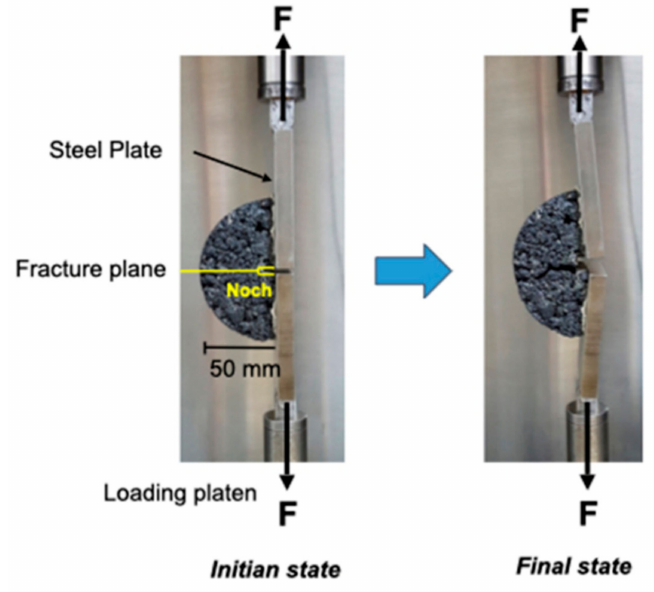
Figure 4. Cracking processes of the specimen by Fenix